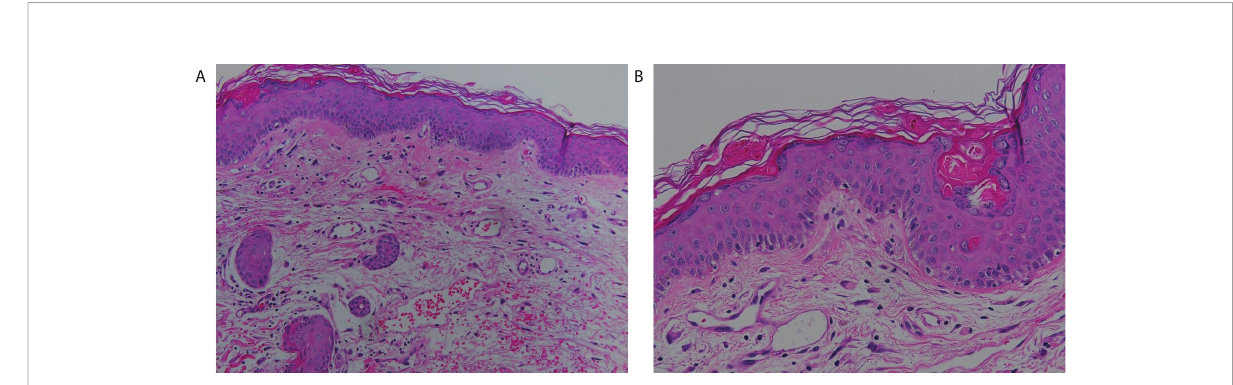
FIGURE 2 Histological features. Skin biopsy demonstrated mild exocytosis, basal layer vacuolization, lymphocyte in fi ltrate at the interface, and mild melanin incontinence (hematoxylin and eosin stain, A : 200×, B : 400×).